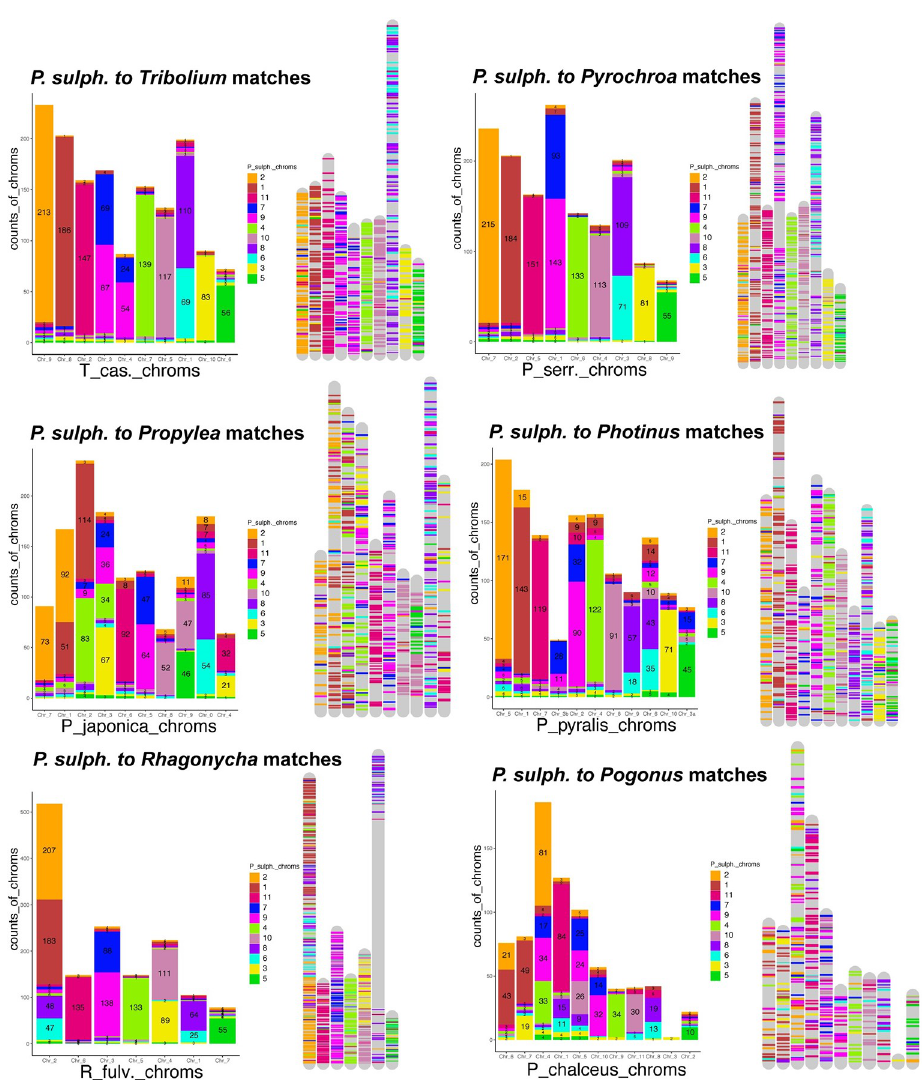
Fig 5. Stacked bar plots and chromosome mappings of BUSCO genes’ placements. The Y-axis represents the counts of BUSCO genes from Pachyrhynchus sulphureomaculatus found on the corresponding chromosomes of another species. Colors correspond to P . sulphureomaculatus chromosomes. The numbering scheme (on X-axis) of chromosomes matches the names found in the genome’s fasta file. While most chromosomes are primarily composed of one or two chromosomes, relative to P . sulphureomaculatus , the placement of the BUSCO genes are interleaved in many instances, indicating that while translocations are rare events reshuffling within a chromosome happens much more